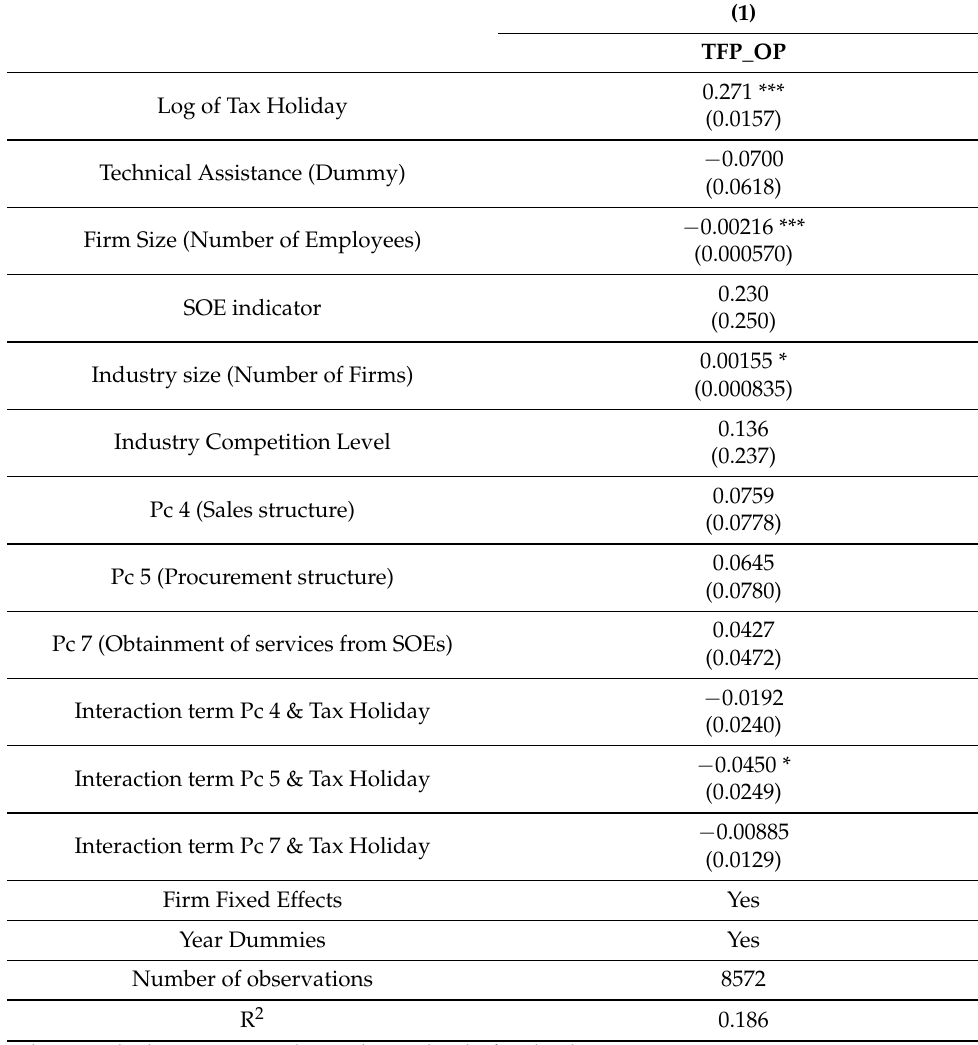
Table 14. Robustness Checks with “Stickier” Political Connection